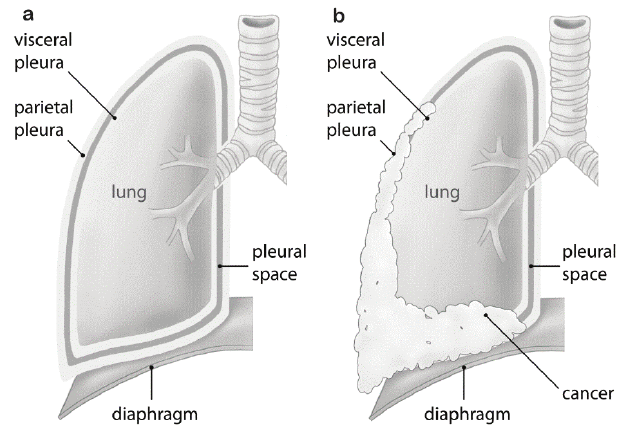
Figure 1. Malignant pleural mesothelioma vs . normal pleura: ( a ) normal pleura; ( b ) malignant pleural mesothelioma growth resulting in compression of the